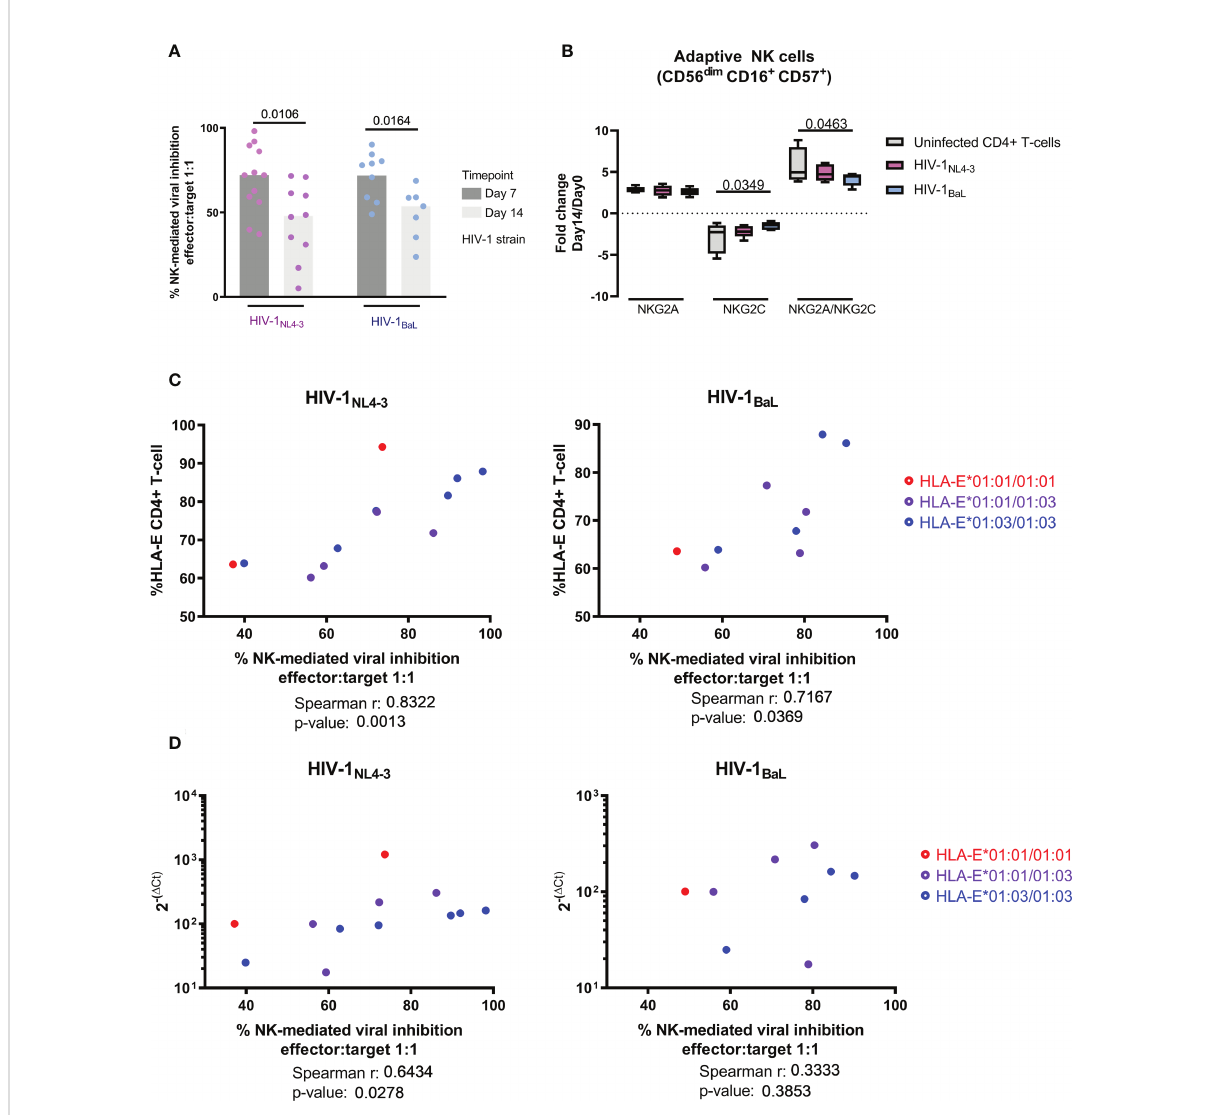
FIGURE 5 Short term NK-mediated inhibition of viral replication is related to HLA-E expression and diminishes over time. (A) Inhibition of viral replication comparing two different laboratory adapted strains (HIV-1 NL4-3 in pink and HIV-1 BaL in blue) and two different timepoints (day 7 in dark grey and day 14 in light grey). (B) Long-term NK-CD4 + T-cell coculture induced changes on the NK HLA-E receptors favoring the expression of the inhibitor NKG2A. HIV infection resulted in higher levels of NKG2C expression as well as a lower level of NKG2A/NKG2C ratios in adaptive NK cells. (C) NK cell control of the viral infection correlated with HLA-E surface expression and basal mRNA levels (D) . Color code indicates sample genotype. Univariate analysis was performed using Wilcoxon test for paired data (A) , while multiple comparisons were performed by one-way ANOVA (B) . Correlation was calculated using Spearman ‘ s rank correlation coef fi cient (C, D) . Results were considered statistically signi fi cant when p-value